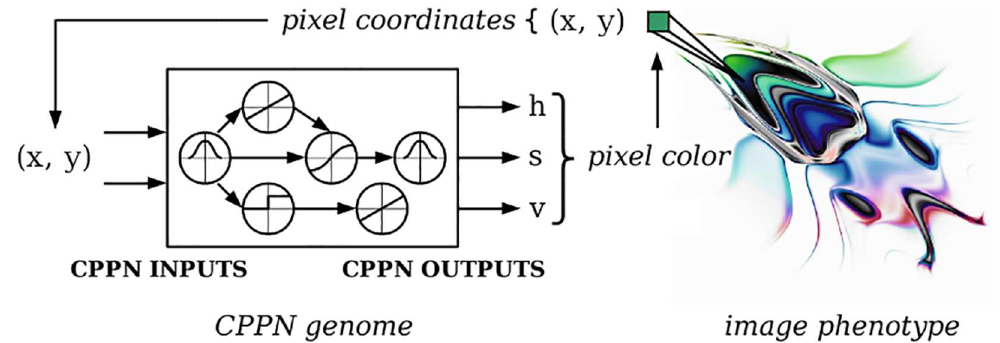
Fig 1. A CPPN genome generates a Picbreeder image phenotype. Adapted from [24]. The x and y coordinates of a pixel in the phenotypeare input to the CPPN, which outputs the hue, saturation, and value components of the pixel color [36]. The process is repeatedfor all pixels in the